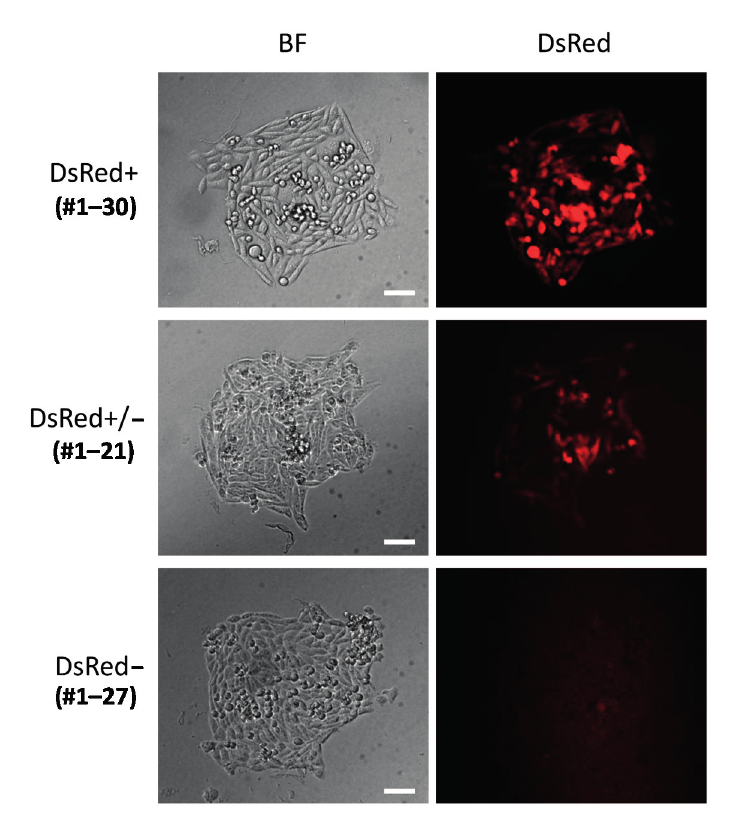
Figure 4. Examples of bright-field and fluorescence images. BF, bright field. Bars, 30 μ